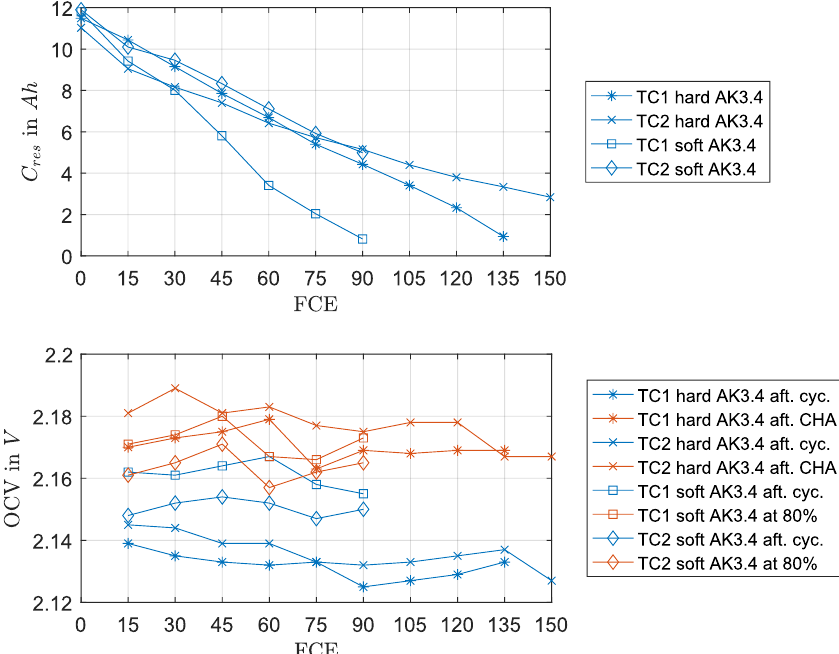
Figure 4. The upper figure shows the residual capacity C res of the test cells in hard AK3.4 and soft AK3.4 aging tests over FCE. The capacities were measured after cycling with a discharge current of − 4I 20 until 1.8V. The lower figure shows the OCV after cycling phase (blue) and after recharging (red) of the test cells over